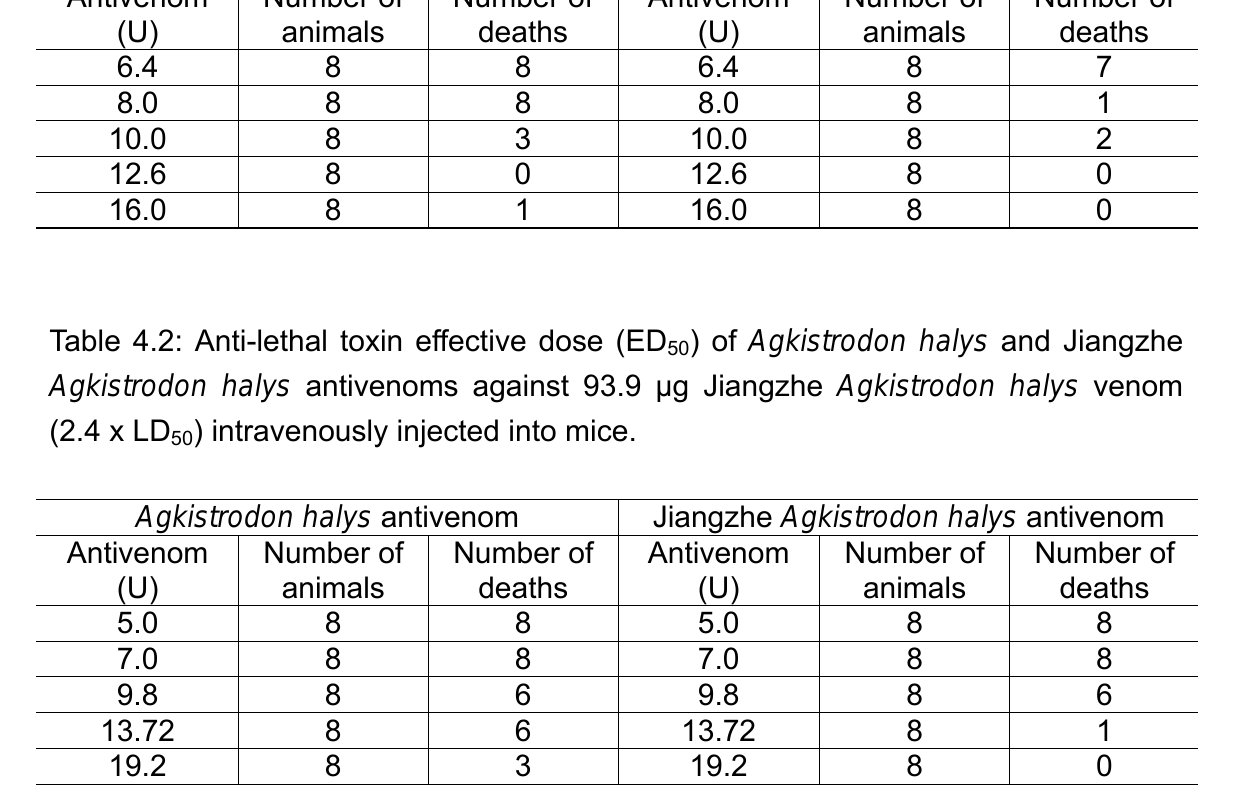
) of Agkistrodon halys and Jiangzhe 50